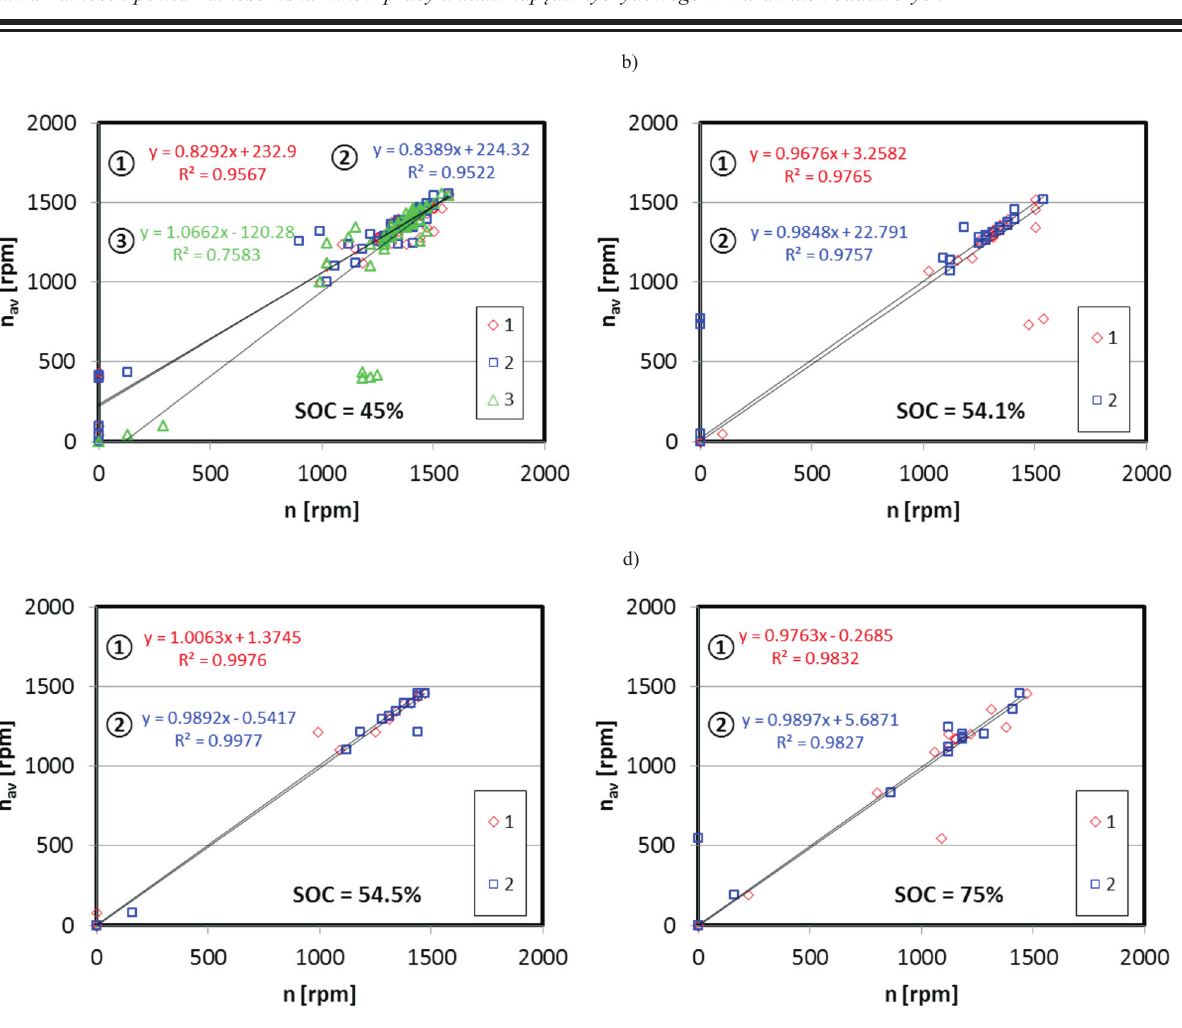
Fig. 10. The analysis of linear regression of average and instantaneous combustion engine speed value in the tests runs at different initial SoC: a) 45%, b) 54.1%, c) 54.5%, d)75% Rys. 10. Analiza regresji liniowej średniej i chwilowej wartości prędkości silnika spalinowego w teście badawczym przy zróżnicowanym początkowym SOC: a) 45%, b) 54,1%, c) 54,5%, d)